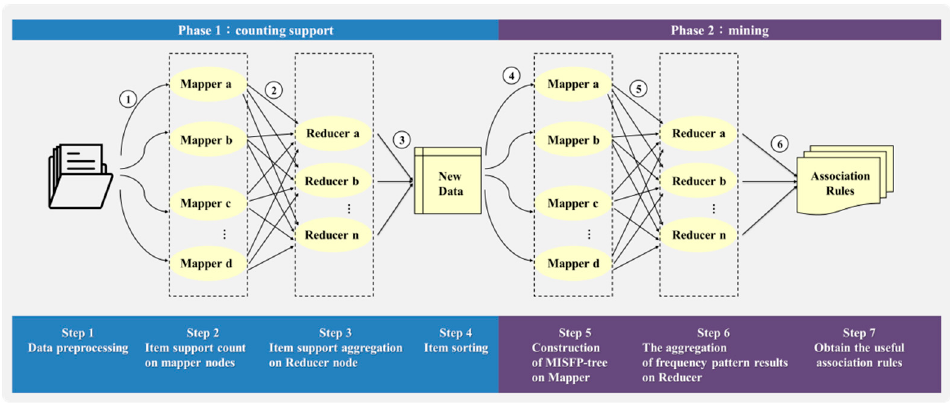
Figure 1. Hadoop-based frequent pattern growth mining architecture.